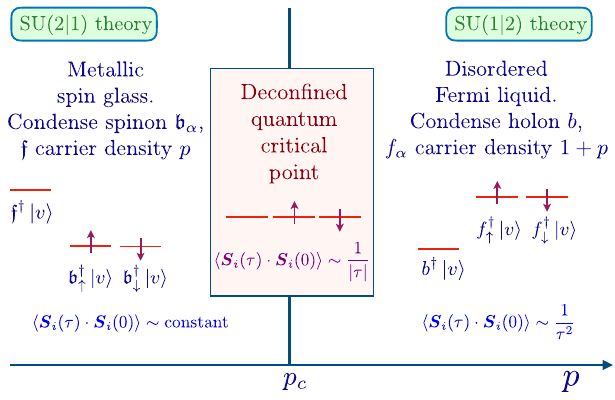
FIG. 1. Proposed phase diagram of H in Eq. (1.1) as a function tJ of hole doping p . The three states on each site are realized either by fermionic spinons ( f α ) and bosonic holons ( b ) with operators as in Eq. (1.3) or by bosonic spinons ( b α ) and fermionic holons ( f ) with operators as in Eq. (1.5); j v i is the holon and spinon vacuum. The three states are nearly degenerate at p ¼ p , which implies c 1 = 3 at zeroth order. The critical theory can be described p c ¼ by both operator representations and exhibits an exact fermion- boson duality. Away from the critical point, the lower-energy state is chosen to be bosonic, and that boson is condensed: So the spinons b α condense for p < p , and the holons b condense for c p > p . The spin correlations of SY [18], decaying as 1 = j τ j , are c realized at p ¼ p . In the impurity model H in Eq. (2.10), c imp increasing p corresponds to increasing s 0